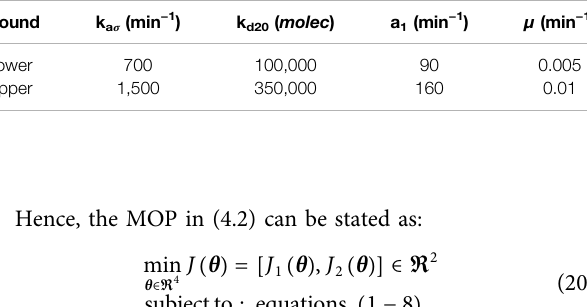
TABLE 1 | Lower and upper bounds for the merging pathway